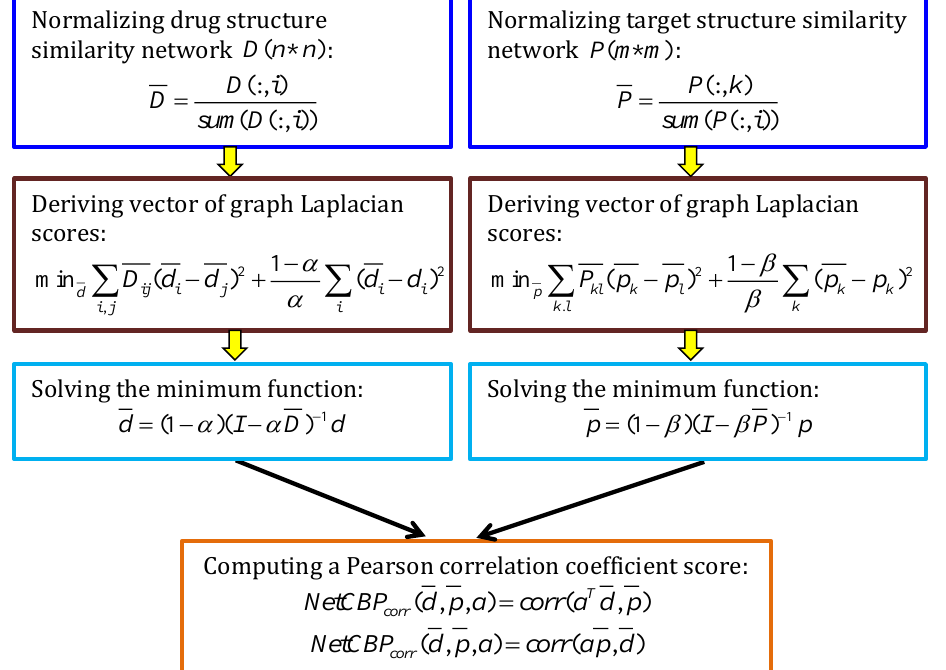
Figure 14. The flowchart of